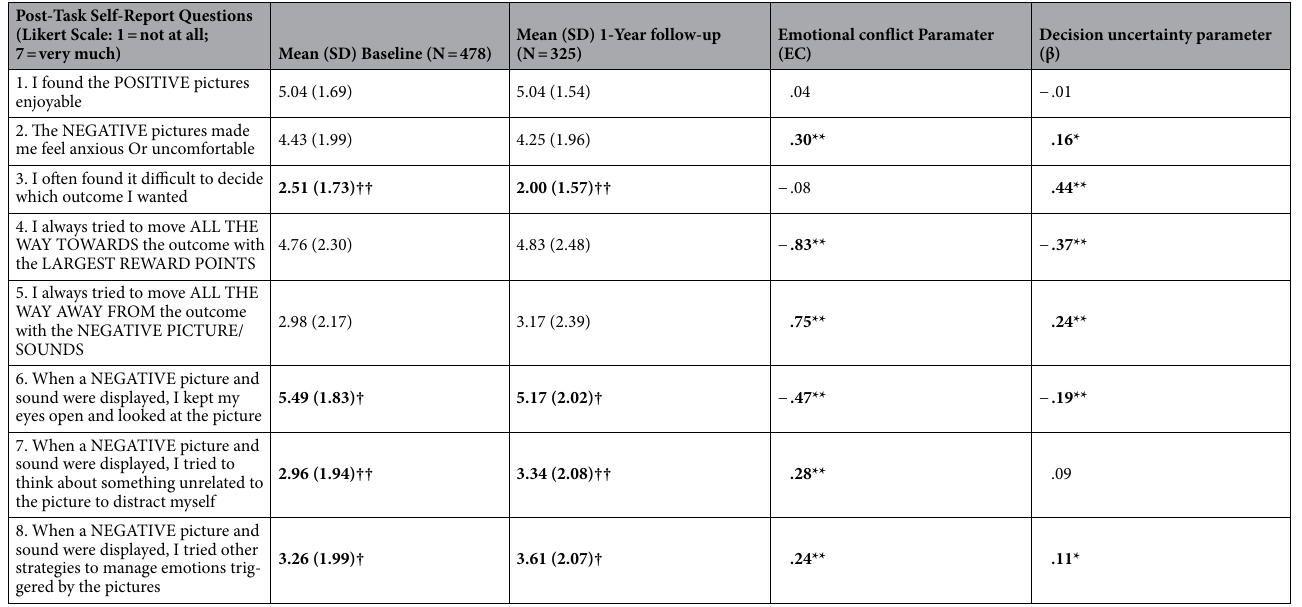
Table 4. Post-task self-report questionnaire items at baseline and follow-up, and correlations with computational model parameters at follow-up. Statistically significent results are highlighted in bold.